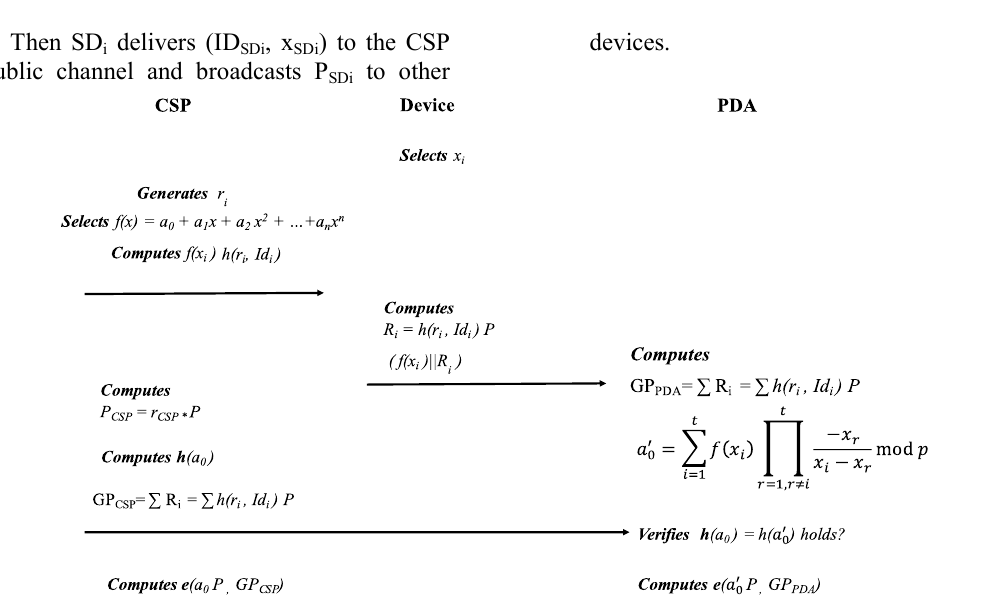
Figure 1. Group authentication phase of the authentication